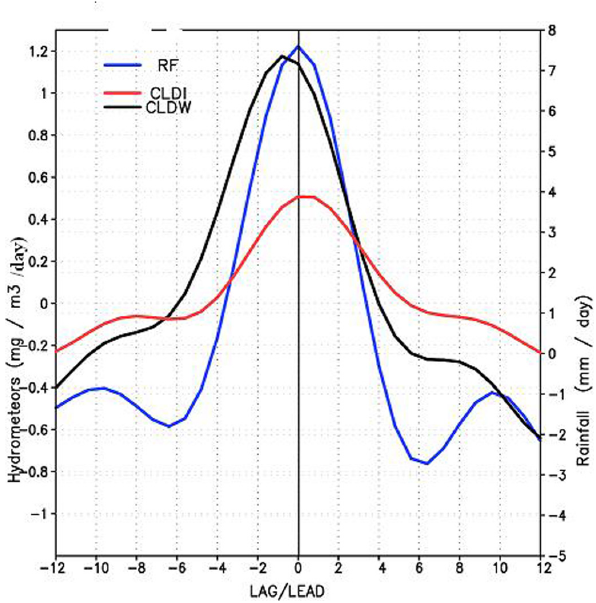
Fig. 7. Domain averaged lag-lead of cloud water (mgm − 3 day − 1 ) and ice (mgm − 3 day − 1 ) with respect to